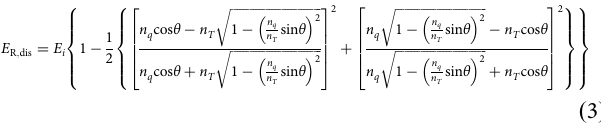
ffiffiffiffiffiffiffiffiffiffiffiffiffiffiffiffiffiffiffiffiffiffiffiffiffiffiffiffiffi